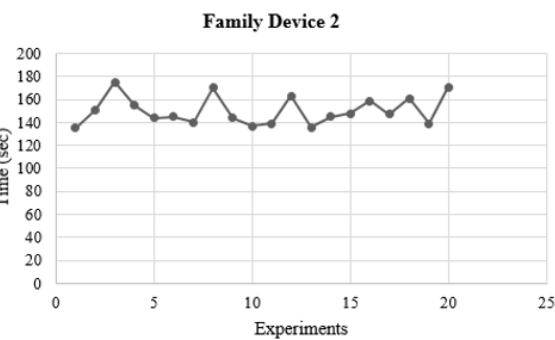
Fig. 7. Patient health monitoring results